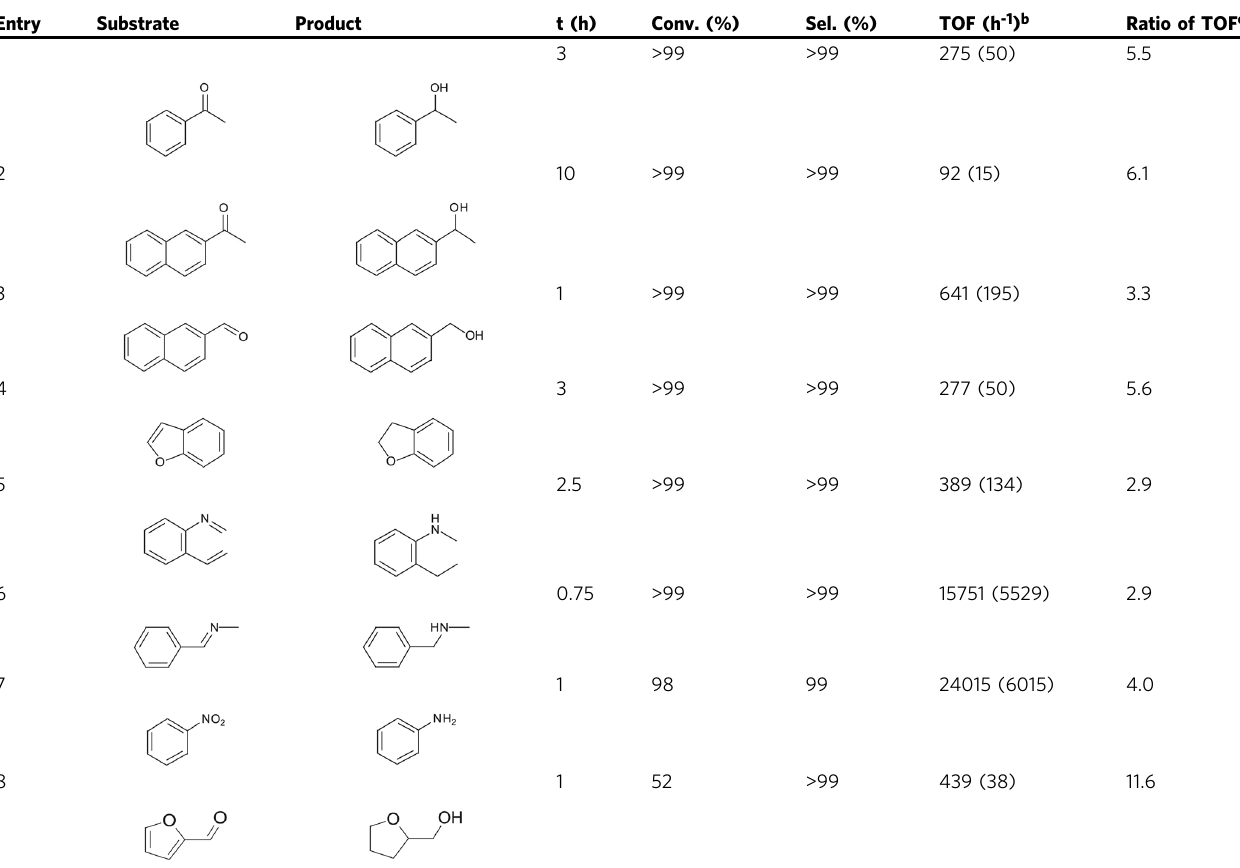
Table 1 Comparison of the activity of Pd/Py-COF and Pd/Be-COF in the hydrogenation reactions a . Entry